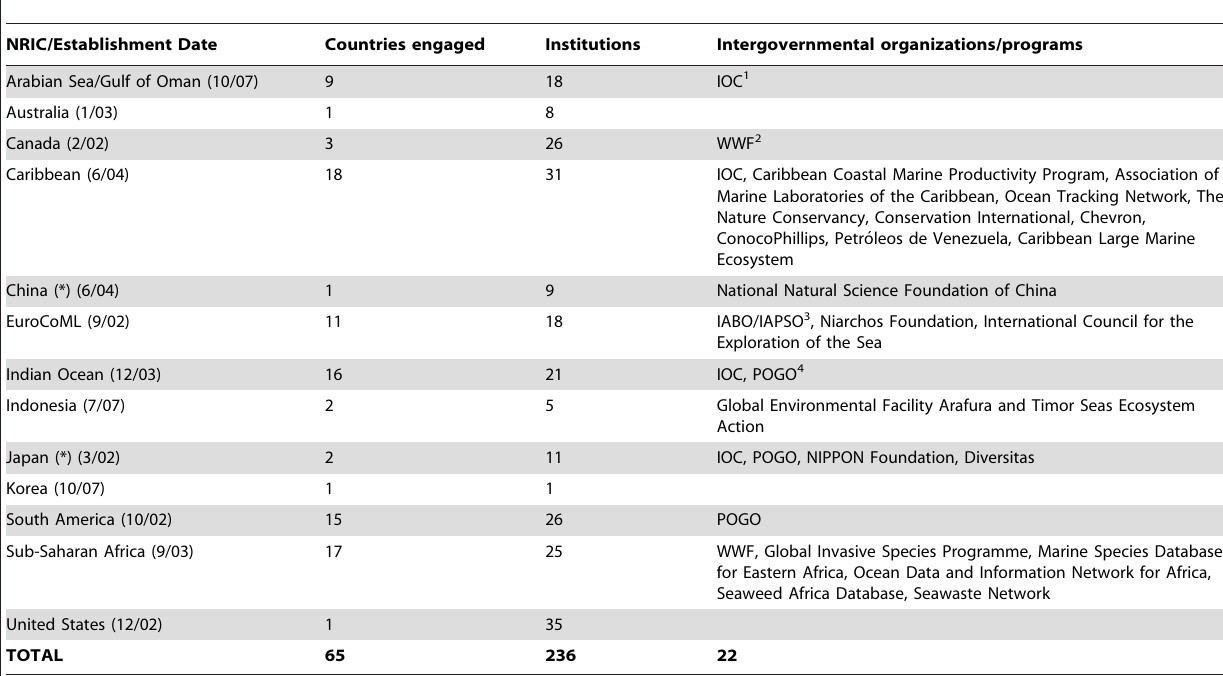
Table 2. International and regional organizations involved in ‘‘known, unknown, and unknowable’’ (KUU) workshops; countries and academic institutions